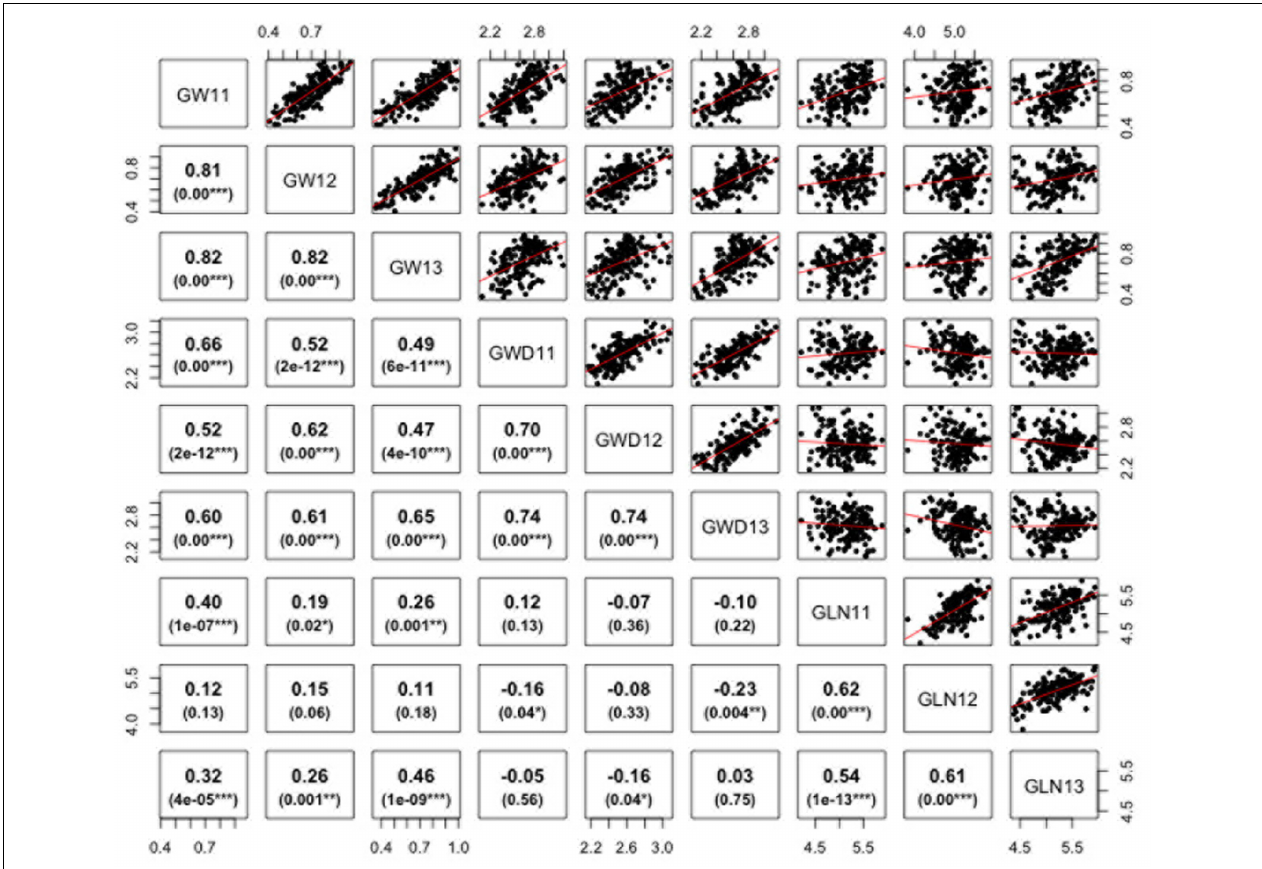
FIGURE 2 | Correlations between grain weight, length, and width in Ae. tauschii for 2011–2013. p -Value for significant correlations is shown at the bottom. ∗∗∗ , ∗∗ , and ∗ , Significant at p < 0.001, p < 0.01, and p < 0.05,